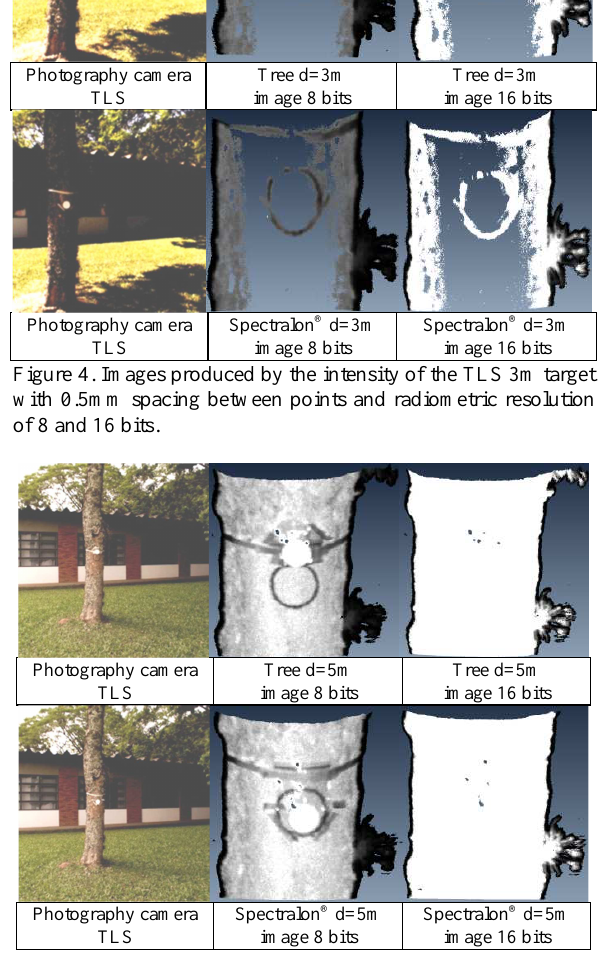
Figure 5. Images produced by the intensity of the TLS 5m target with 0.5mm spacing between points and radiometric resolution of 8 and 16 bits.